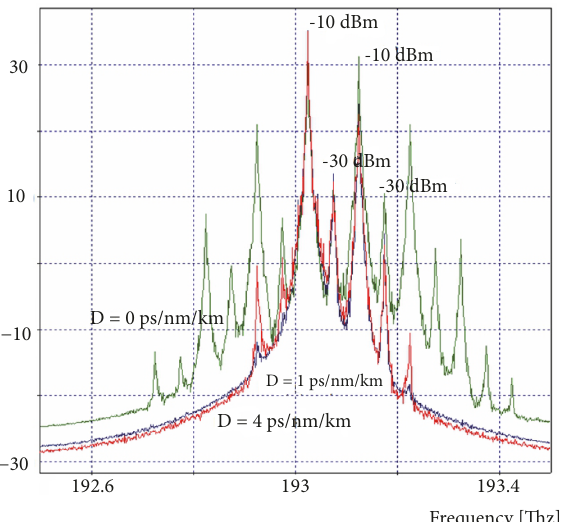
the dispersion with an increment of 1 from 0 ps/nm/ km to 4 ps/nm/ km at different power transmissions (Figure 3).